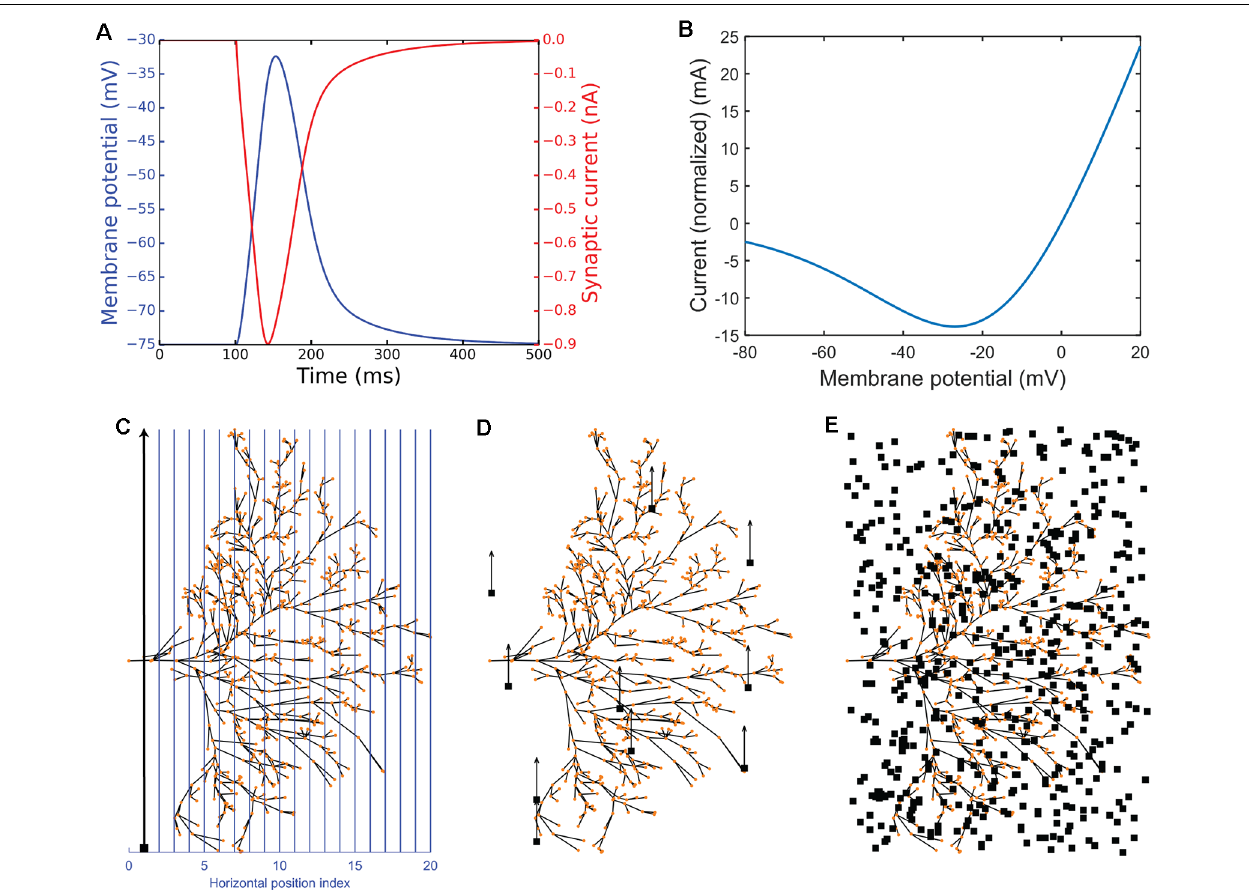
FIGURE 3 | Experimental simulation protocols. Panels (A,B) illustrate NMDA receptor characteristics. (A) Impulse response showing membrane potential (blue) and synaptic current (red). (B) The plot of the macroscopic NMDA receptor current (shown as normalized current). It is essentially all the voltage-dependent parts (cid:1) . (C–E) Illustration of the experimental protocols. The red dots represent the dendritic sections which have been given one normalized by multiplying by (cid:0) 1 + [ Mg ] 3.57 NMDA receptor each. The neuron is viewed from the anterior side of the brain ( Figure 1A ). (C) The continuous experimental setup where blue lines show the vertical trajectories on which the small target (black target) travels (in the direction of the black arrow) with 500 steps (ms). (D) The short experimental setup where a target starts at a random position and travels up for 50 ms, switches to a new random position, travels up for 50 ms again, and repeats this 10 times in total (500 ms). (E) The random experimental setup showing an example of 500 random positions (500